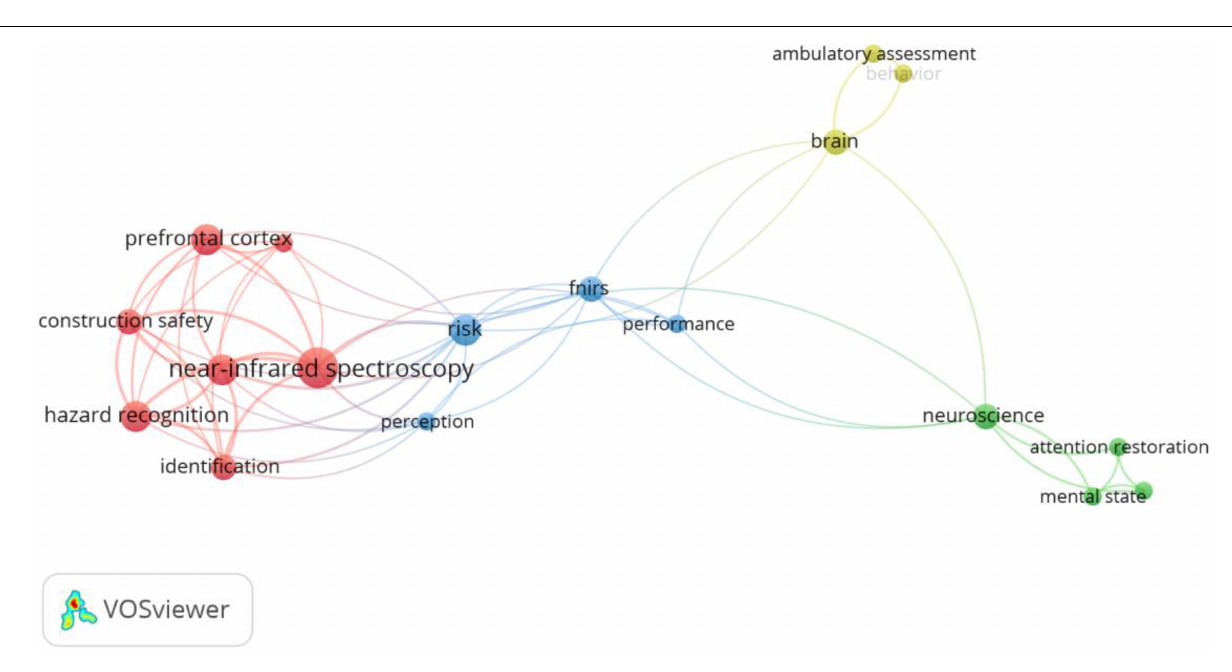
FIGURE 12 | Keywords co-occurrence network of